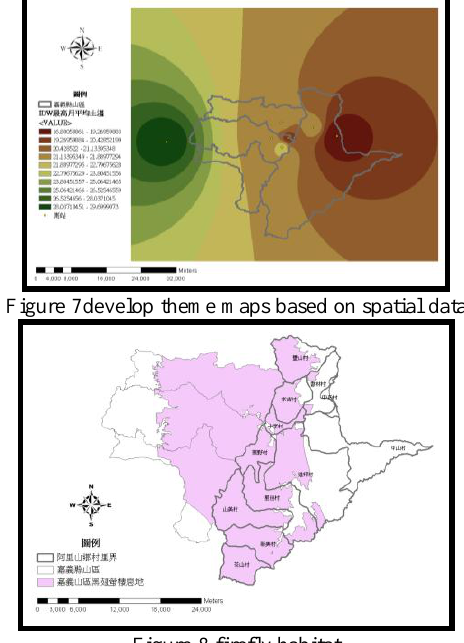
Figure 8 firefly